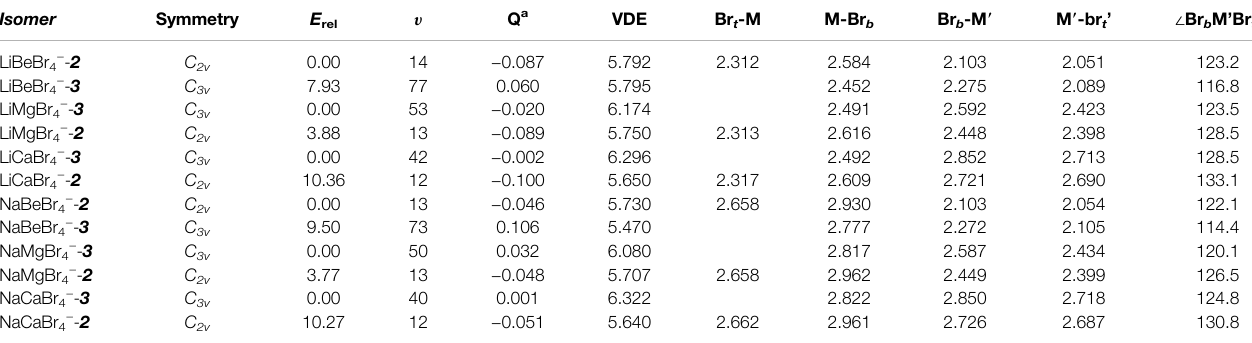
TABLE 2 | Relative energies E rel (kcal/mol), the lowest vibrational frequencies υ (cm − 1 ), total NBO charges on MBr subunit (|e|), vertical detachment energies VDE (eV), bond lengths (Å), and select bond angles (degree) of the MM ′ Br 4 − (M = Li, Na; M ′ = Be, Mg, Ca) anions. Isomer Symmetry E